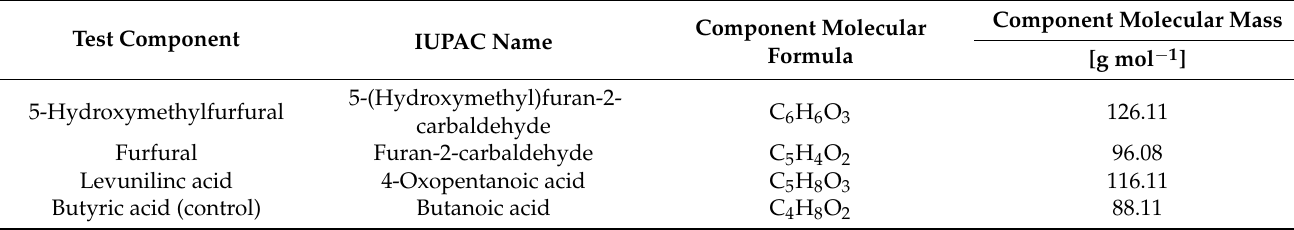
Table 1. Characteristics of the selected components of 5-hydroxymethylfurfural (5-HMF) process-wastewater utilized in this